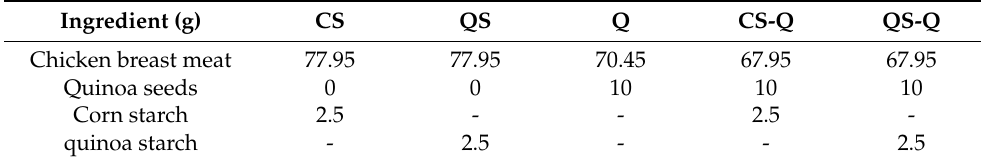
Table 1. Formulations of the chicken meatballs with quinoa seeds and starch. Ingredient (g) CS QS Q CS-Q QS-Q Chicken breast meat